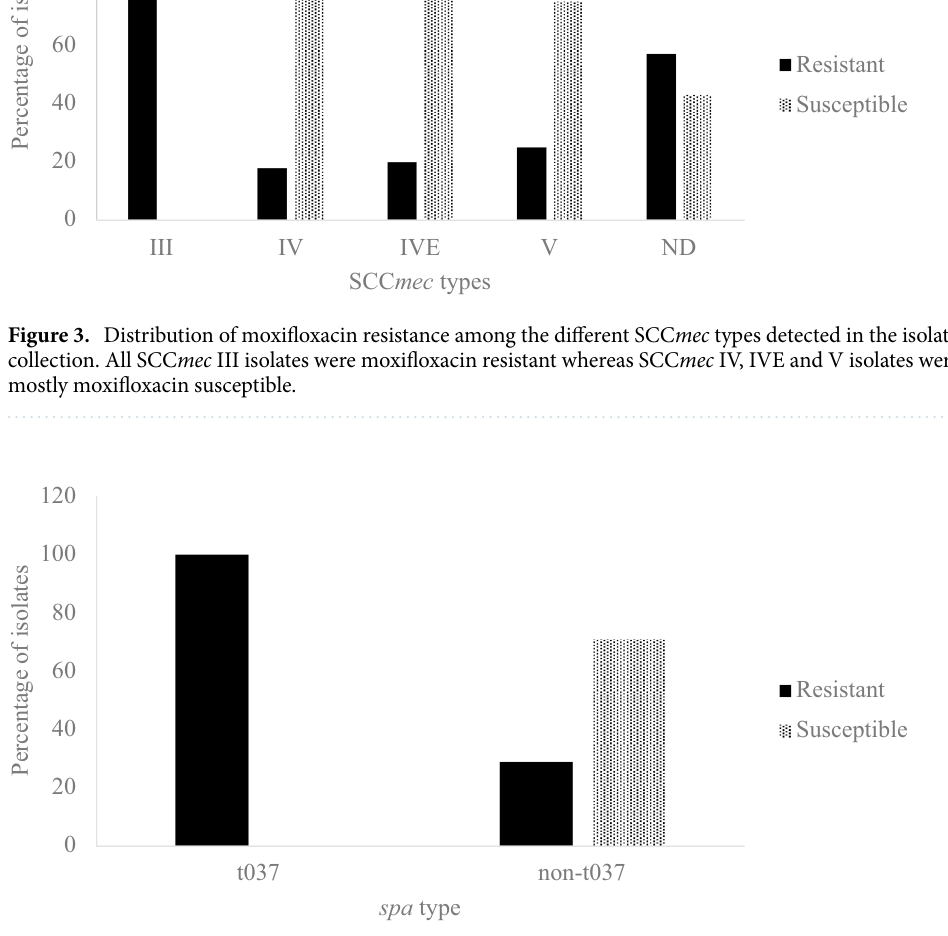
Figure 4. Distribution of moxifloxacin resistance among the spa types detected in the isolate collection. All isolates belonging to spa type t037 were moxifloxacin resistant. Isolates belonging to all other spa types were mostly (71%) moxifloxacin